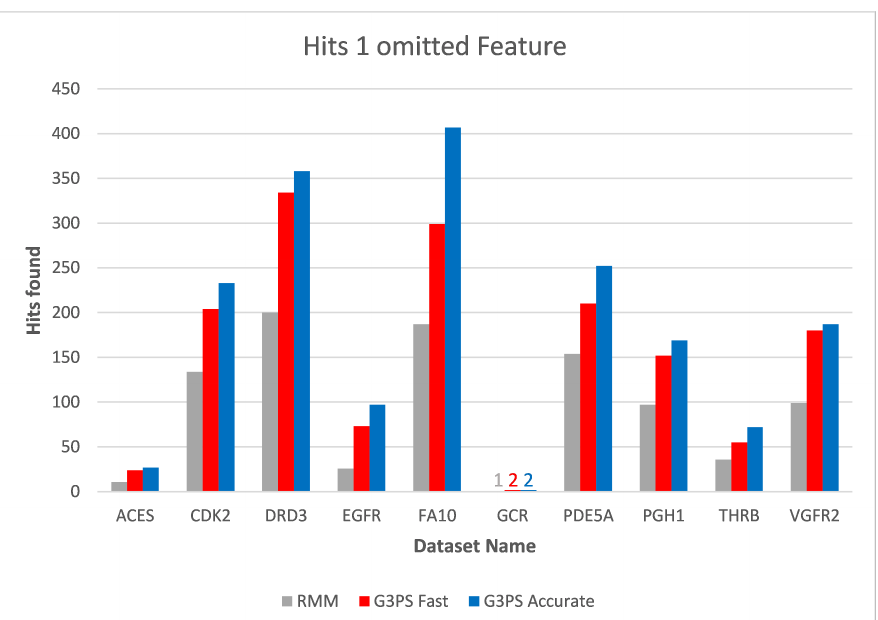
Figure 13. Screening benchmark hits with one omitted